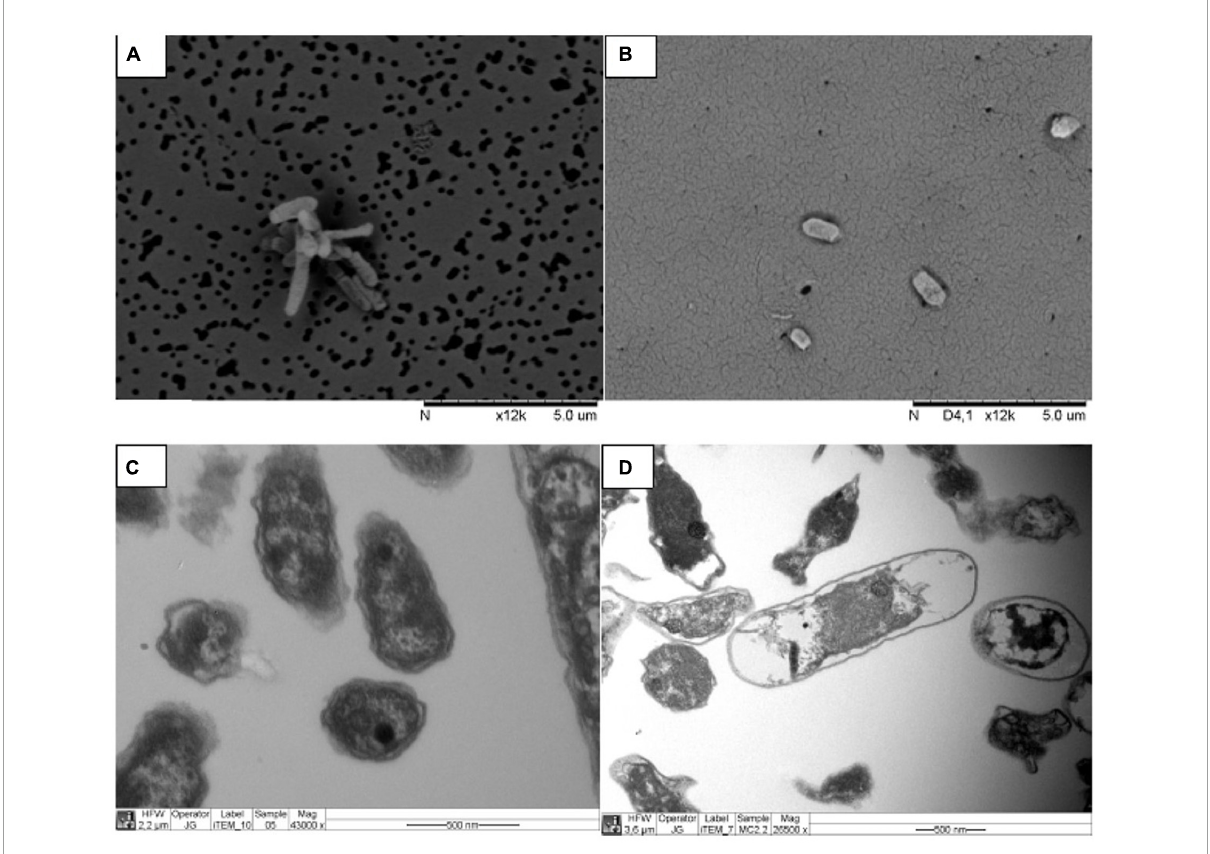
FIGURE2 Electron microscopy images of strains grown at 20 ◦ C. Strains PG05 (A) and MC2.2 (B) visualized by SEM. Strains PG05 (C) and MC2.2 (D) visualized by TEM.